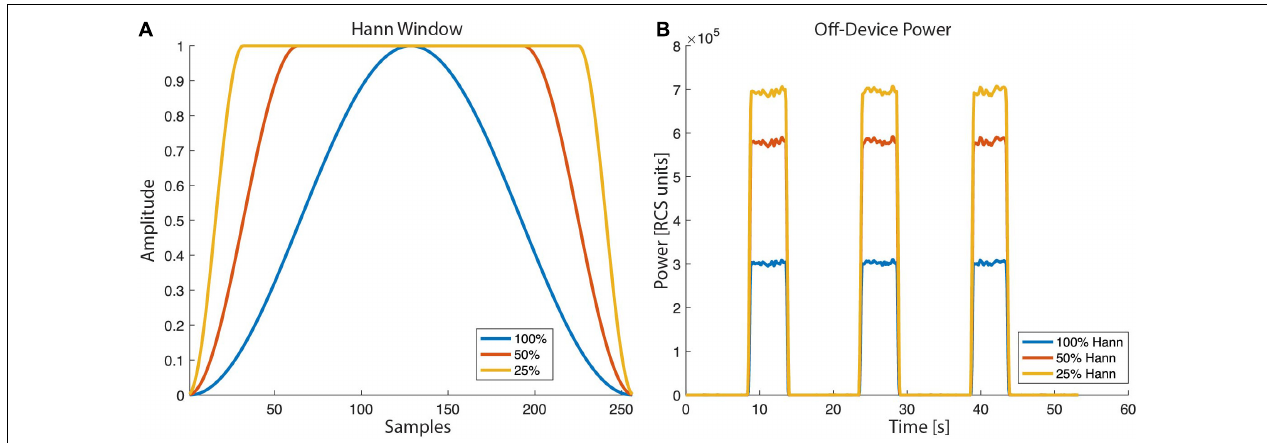
FIGURE 8 | Hann window with “window load” parameter of 25, 50, and 100% as selectable by the RC+S FFT power calculation: (A) The shape of the tapper Hann window function. (B) Power calculated off-device based on different Hann window load values.